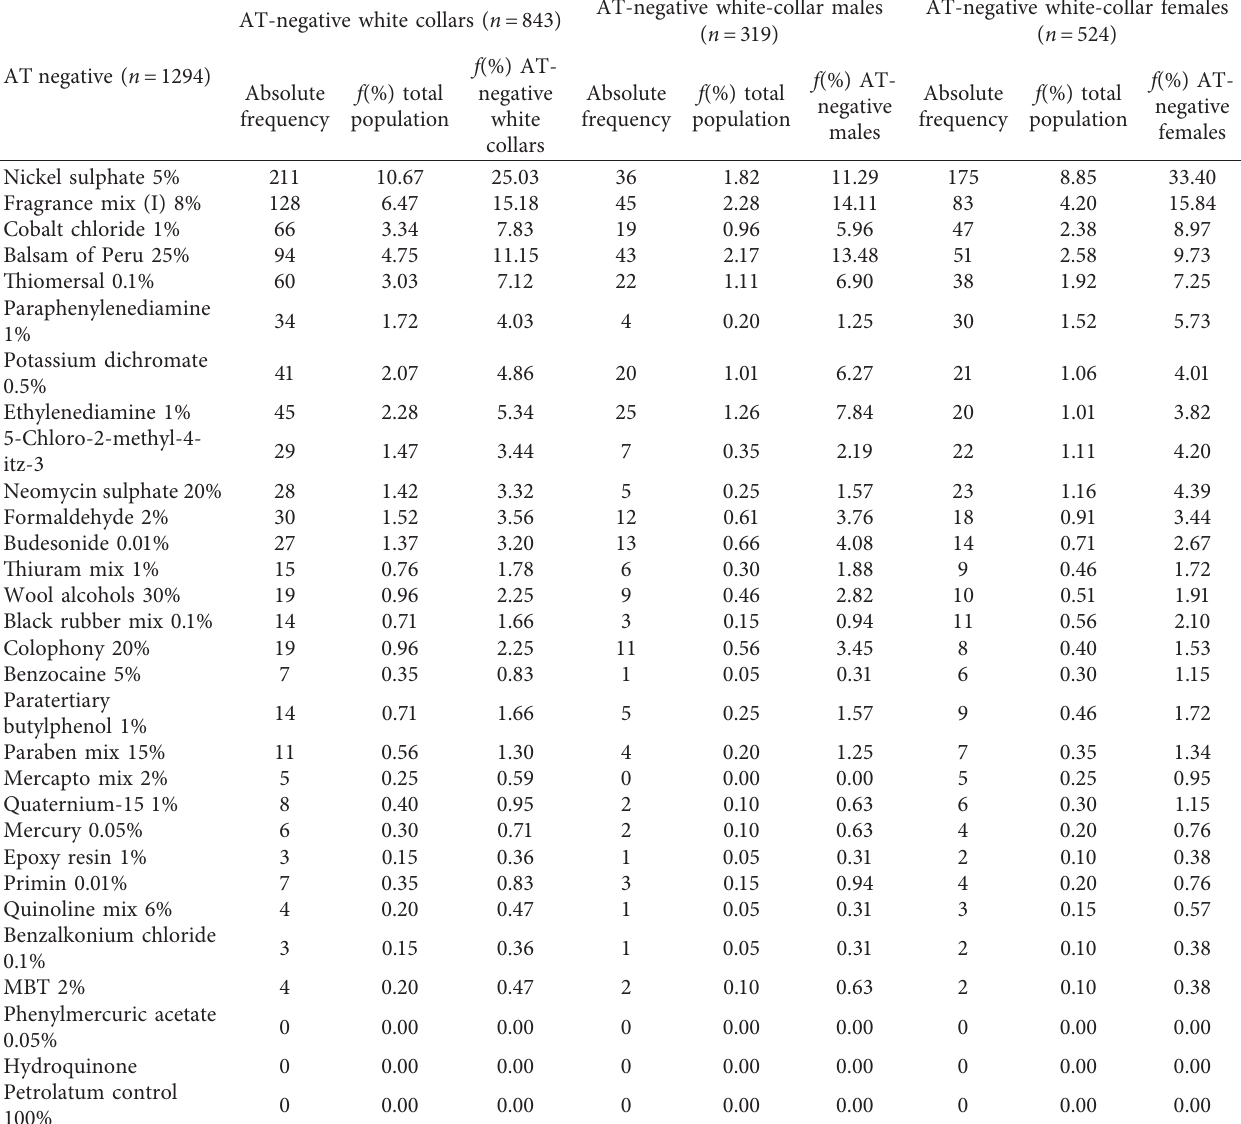
Table 6: Frequencies of the most prevalent allergens in the population without atopic dermatitis (AT), with respect to the white-collar (WhC) population, as well as the male and female WhC population.